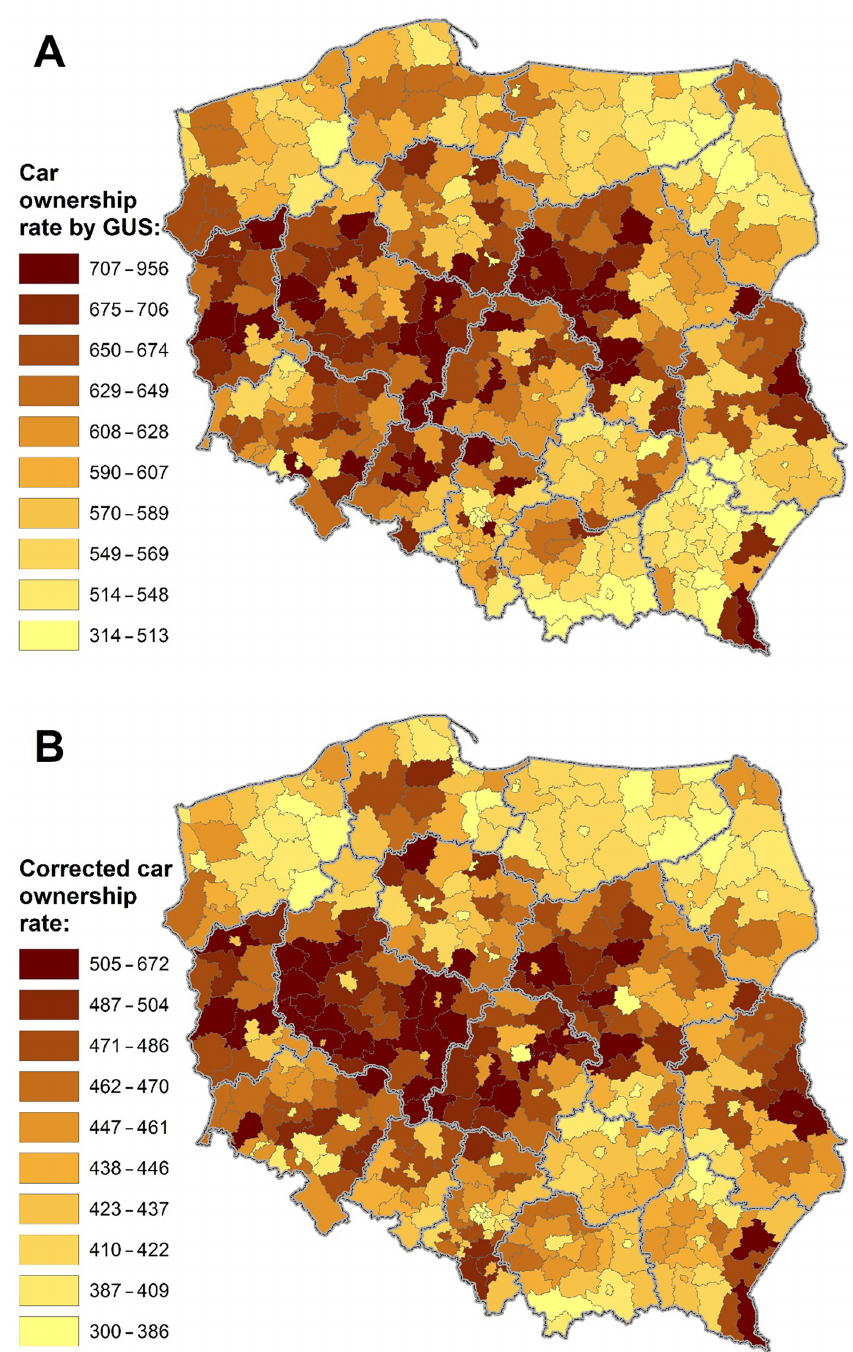
Fig. 5. Spatial distribution of car ownership rate values in Poland, in line with data from GUS (A) and CEP, as corrected by the authors (B) (31 December